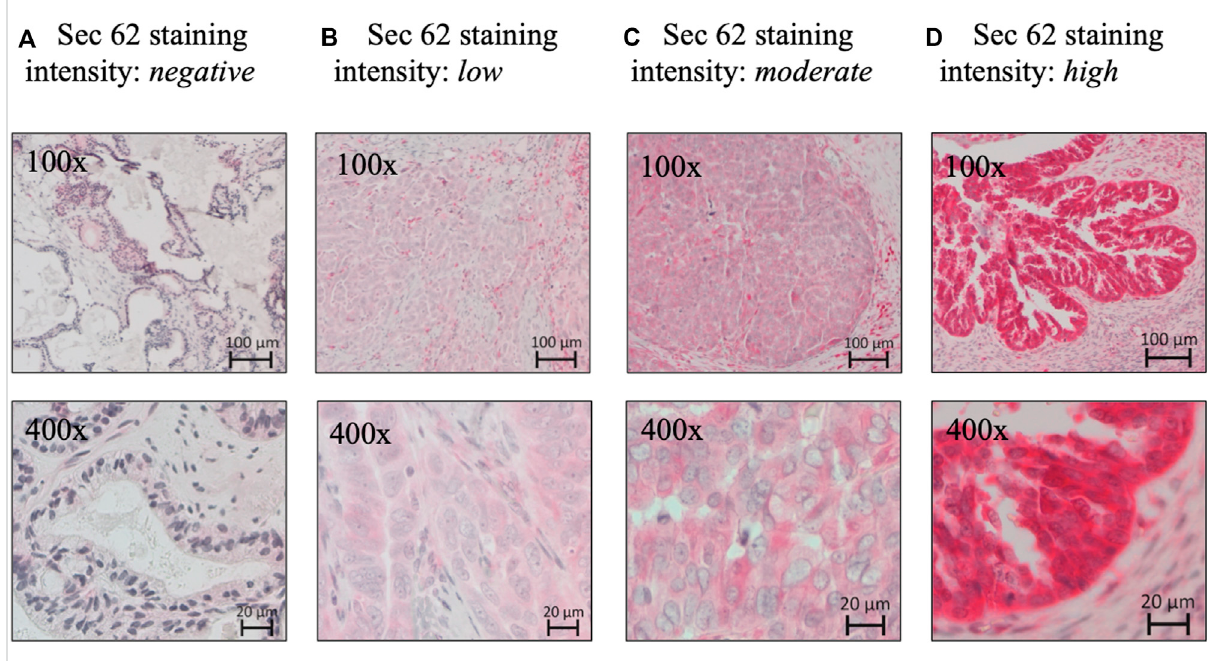
FIGURE 1 Sec62 immunohistochemistry. (A) Negative SEC62 expression in normal ovarian tissue, as well as low (B) , moderate (C) , and high immunostaining intensity (D) in serous ovarian cancer. SEC62 expression is indicated by a red signal, counterstaining with hematoxylin (blue).